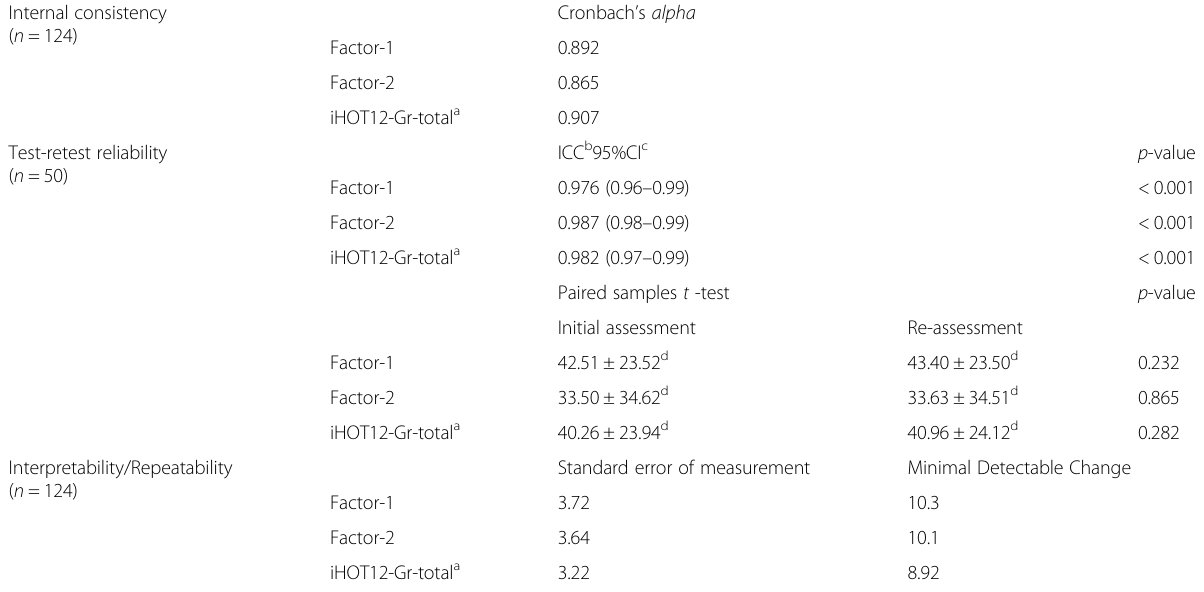
Table 3 Reliability properties of the international Hip Outcome Tool (12 items) - Greek